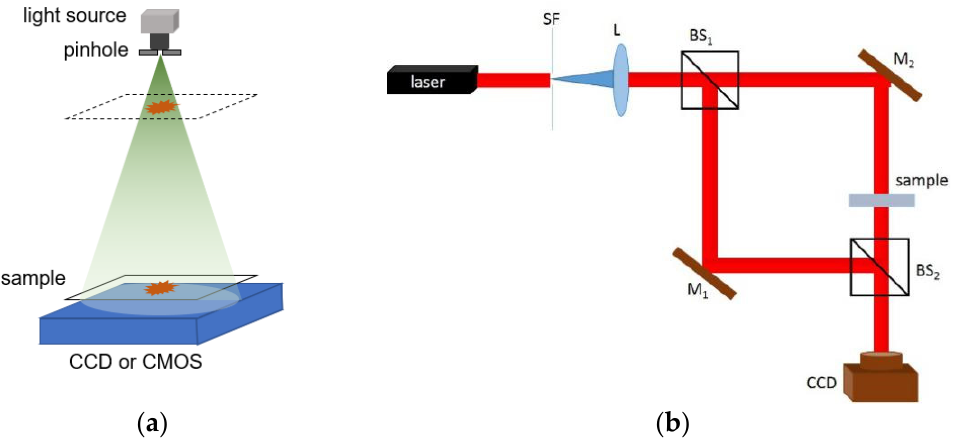
Figure 1. In-line digital holography schematic. ( a ) Lensless in-line holographic system schematic. ( b ) Mach–Zehnder interferometer-based holographic system schematic.